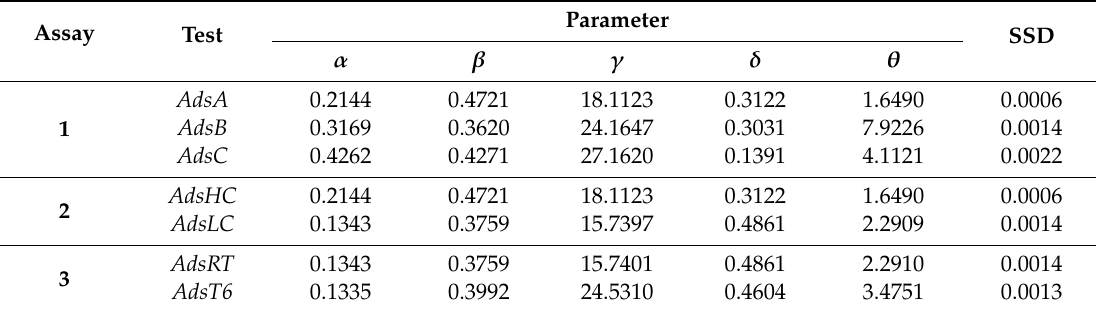
Table 7. Determination of parameter estimates and sum of squared di ff erences (SSD) by MS Solver for adjustment of adsorption kinetic